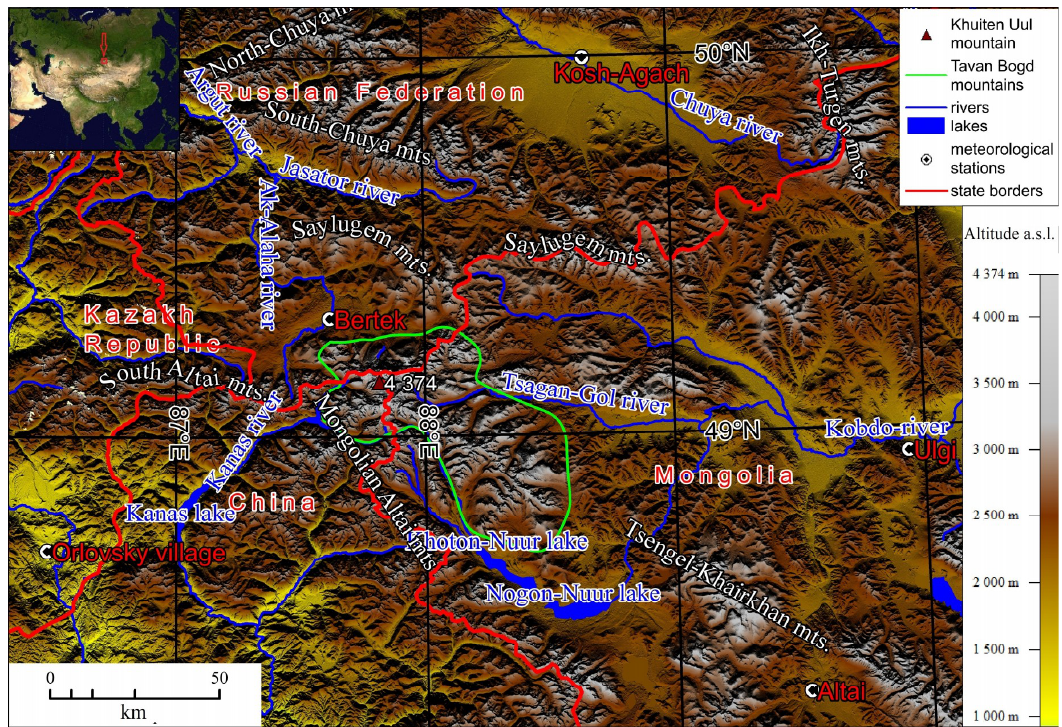
Figure 1. Geographical location of the Tavan Bogd mountain range.